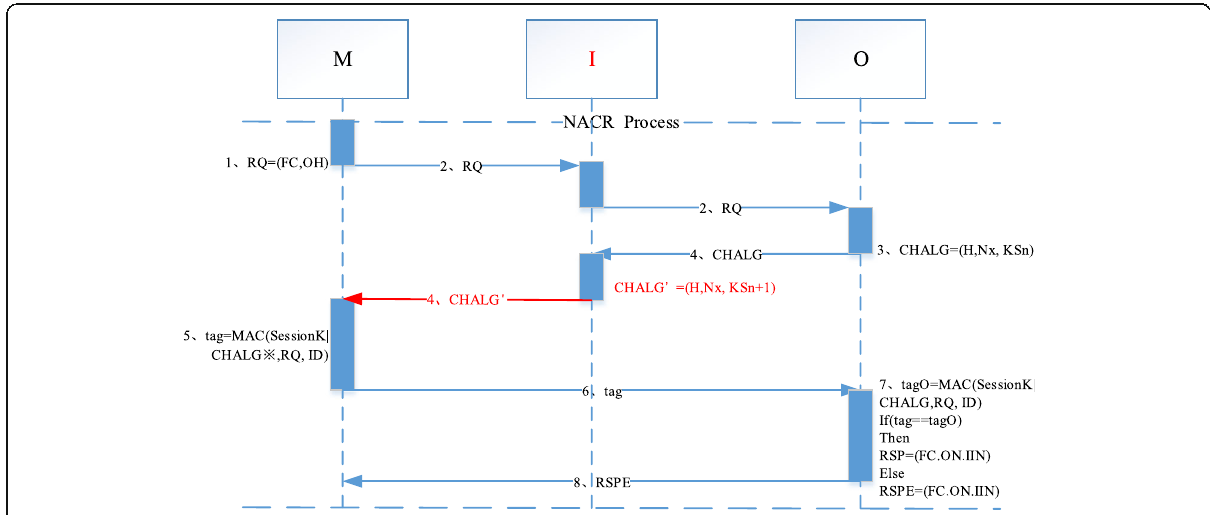
Fig. 2 The MSC model of first